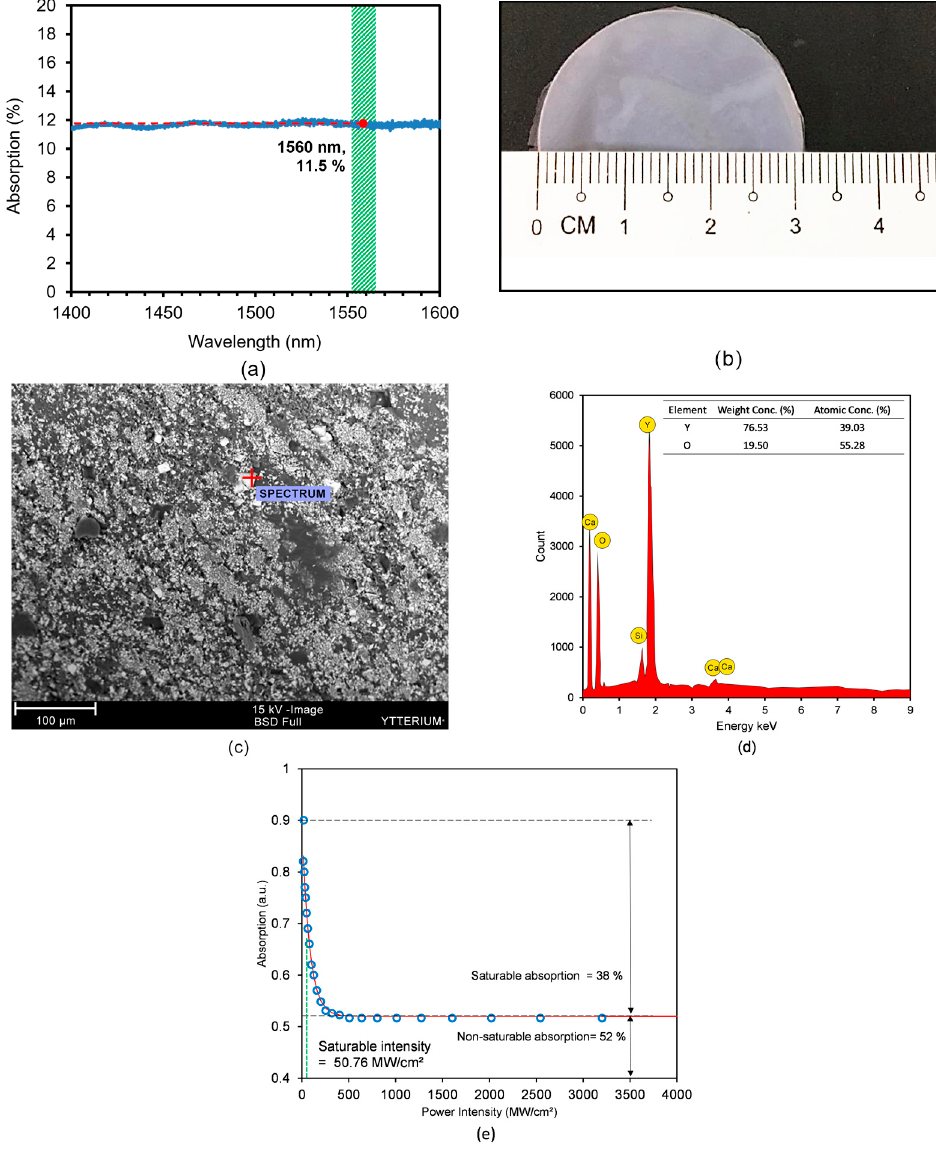
Figure 2. ( a ) linear absorption profile of Y 2 O 3 -PVA, ( b ) physical image of Y 2 O 3 -PVA film, ( c ) surface morphology analysis of Y 2 O 3 -PVA using SEM with red cross mark showing the position of EDX analysis, ( d ) elemental analysis using EDX, and ( e ) modulation depth of Y 2 O 3 -PVA film with green and red dotted lines shows the saturable intensity and saturable absorption percentage